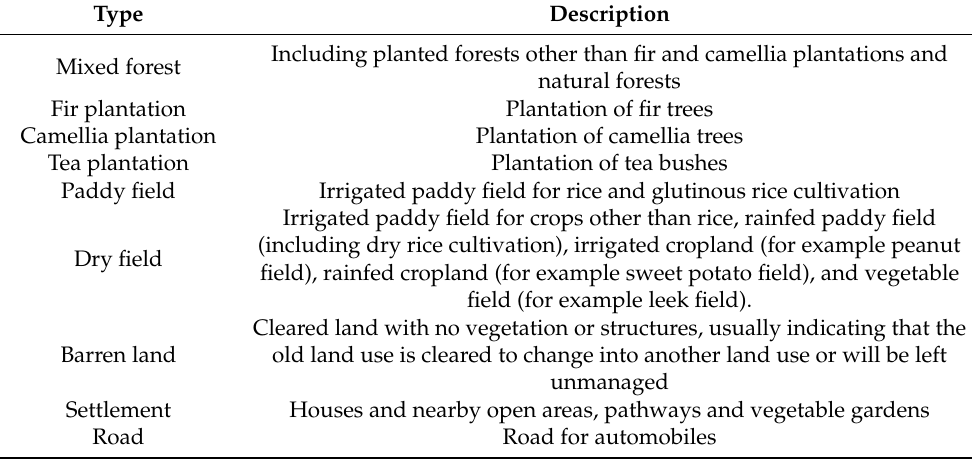
Table 2. Land use types.